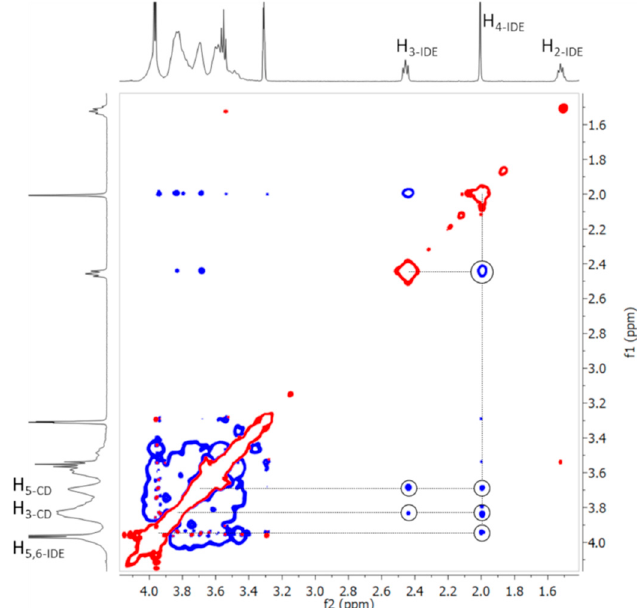
Figure 13. Expansion of two-dimensional (2D) rotating frame Overhauser effect spectroscopy (ROESY) plot of IDE/HP- β -CD complex in D 2 O/MeOD, showing the NOEs (blue) of interest.